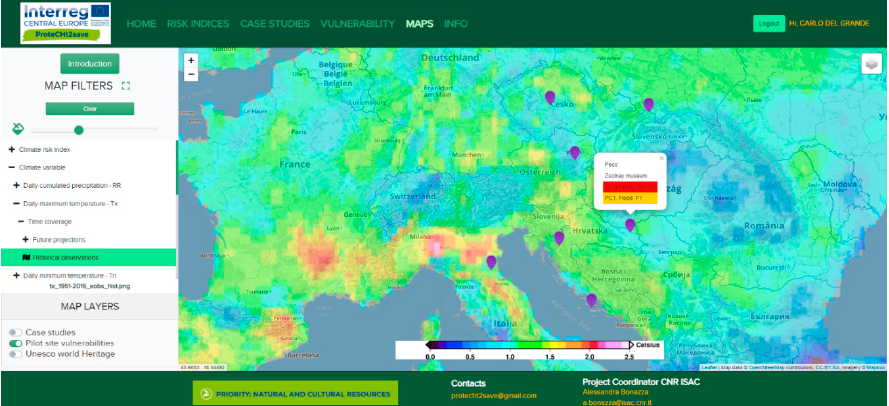
Figure 4. Screenshot from the Web GIS tool website showing a hazard map obtained with the historical observations of daily maximum temperature. The vulnerability rate for the case study in Hungary (Pecs) is also illustrated.